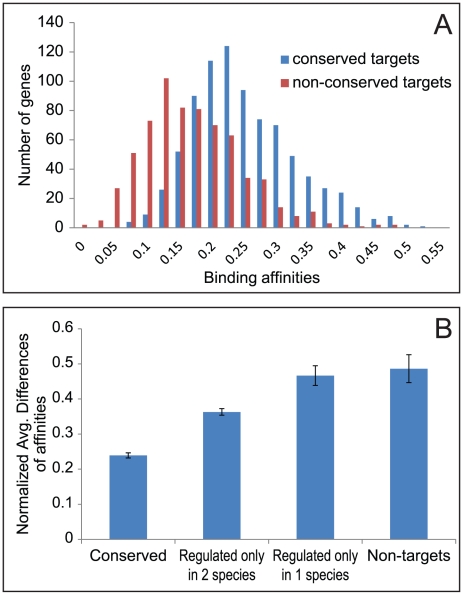
Relationship between conservation and binding affinities.(A) The distribution of the average binding affinities between Oct4 and orthologous regulatory sequences in three species. (B) Interspecies difference in binding affinities of the 20 kb upstream sequences of orthologous genes. The orthologous genes are put into four categories of conservation. Error bars show 95% confidence intervals.